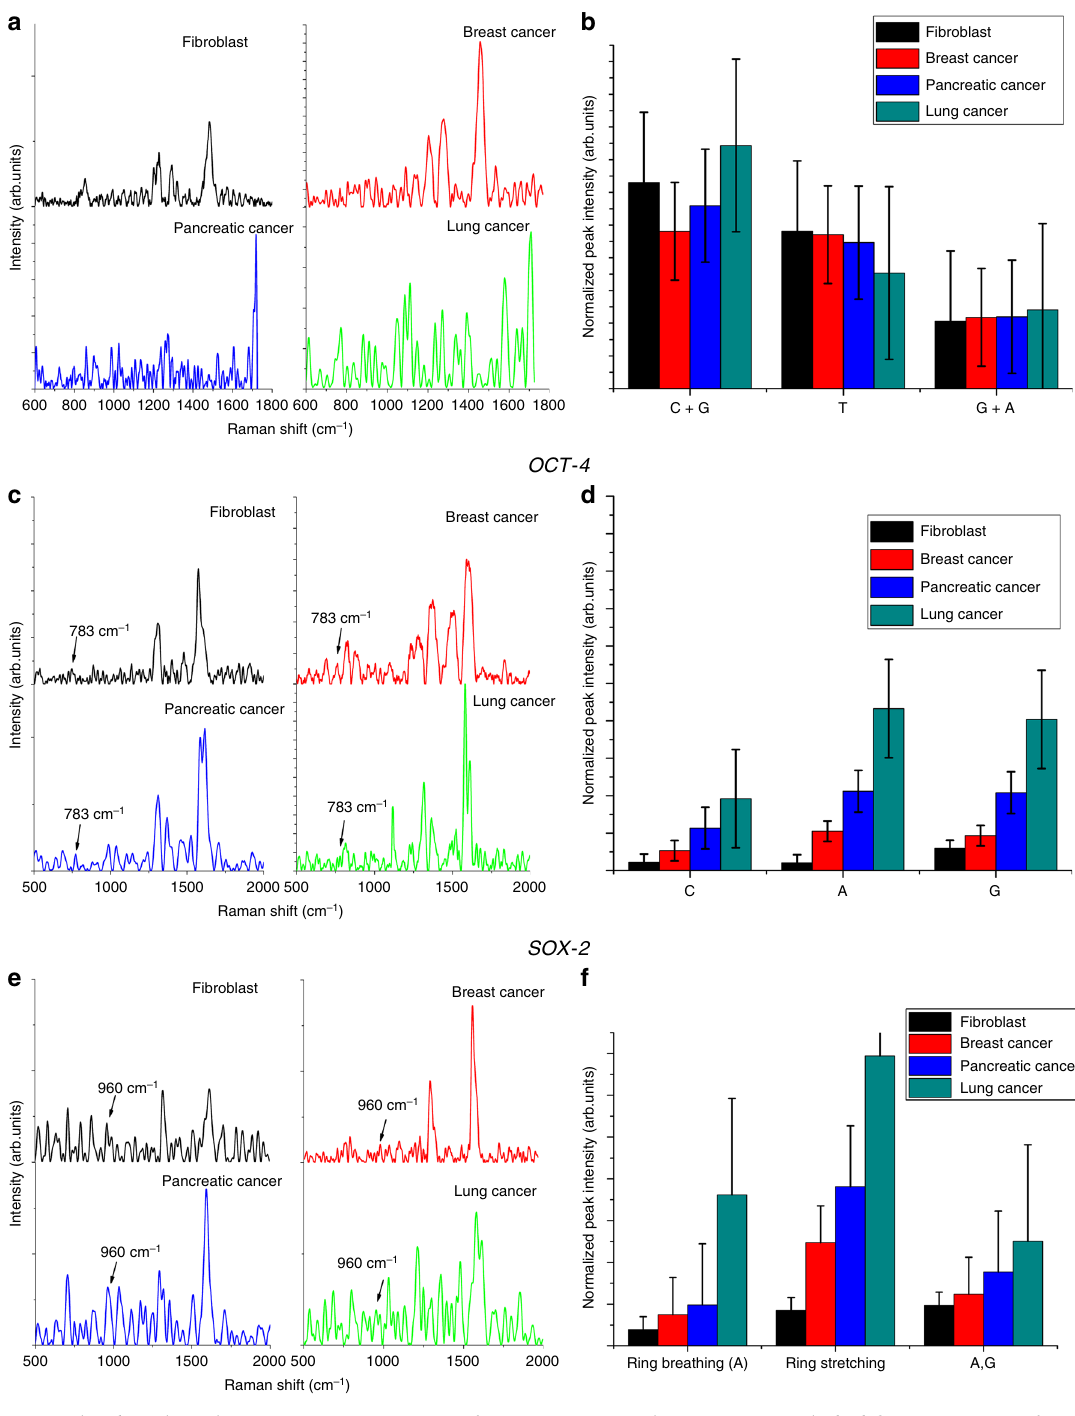
Fig. 8 Gene expression detection using QOS. a , c , e SERS spectra of GAPDH, OCT-4, and SOX-2, respectively, b , d , f expression ratio of GAPDH, OCT-4, and SOX-2,